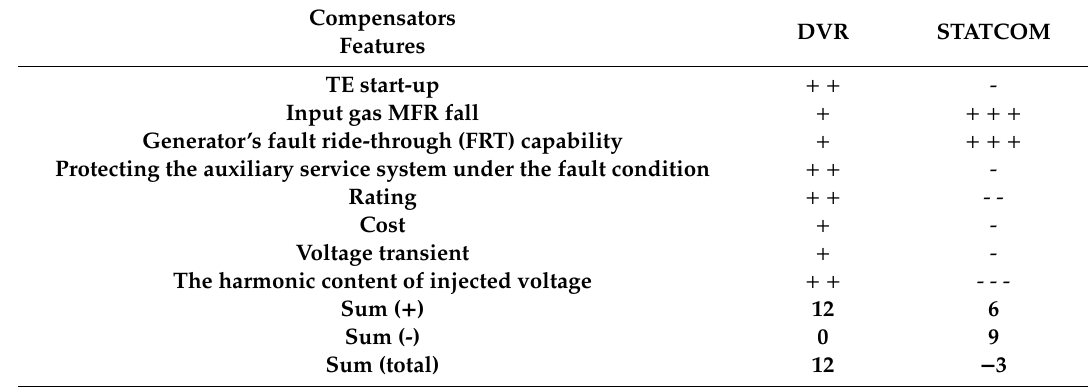
Table 7. Summary of techno-economic assessment for this case study with the grading: superior ( + + + ), very good ( + + ), good ( + ), poor (-), very poor (- -), and inferior (- - -). Compensators DVR STATCOM Features TE start-up + + - Input gas MFR fall + + + + Generator’s fault ride-through (FRT) capability + + + + Protecting the auxiliary service system under the fault condition + + - Rating + + - - Cost + - Voltage transient + - The harmonic content of injected voltage + + - - - Sum ( +